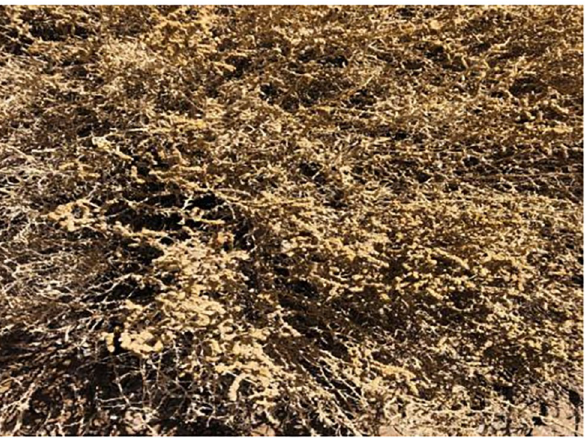
Fig 5. A photograph of halophytic plants ( Kalidium ) growing in the downstream of West Tai River (taken on 24 April, 2019 around i# sampling point).